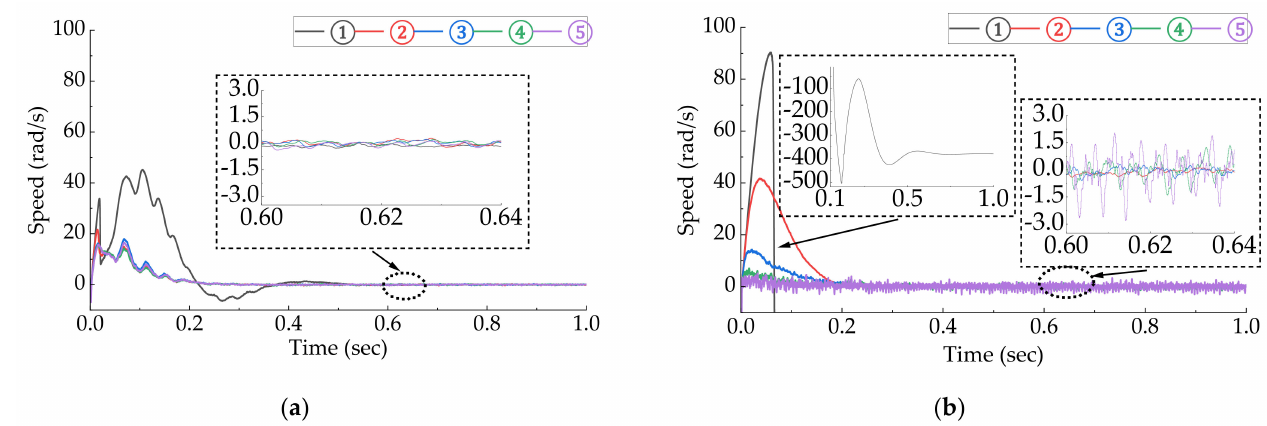
Figure 3. ( a ) When the Q value is 1 (cid:13) – 5 (cid:13) , the speed is estimated by the PAEKF. ( b ) When the Q value is 1 (cid:13) – 5 (cid:13) , the speed is estimated by the EKF.